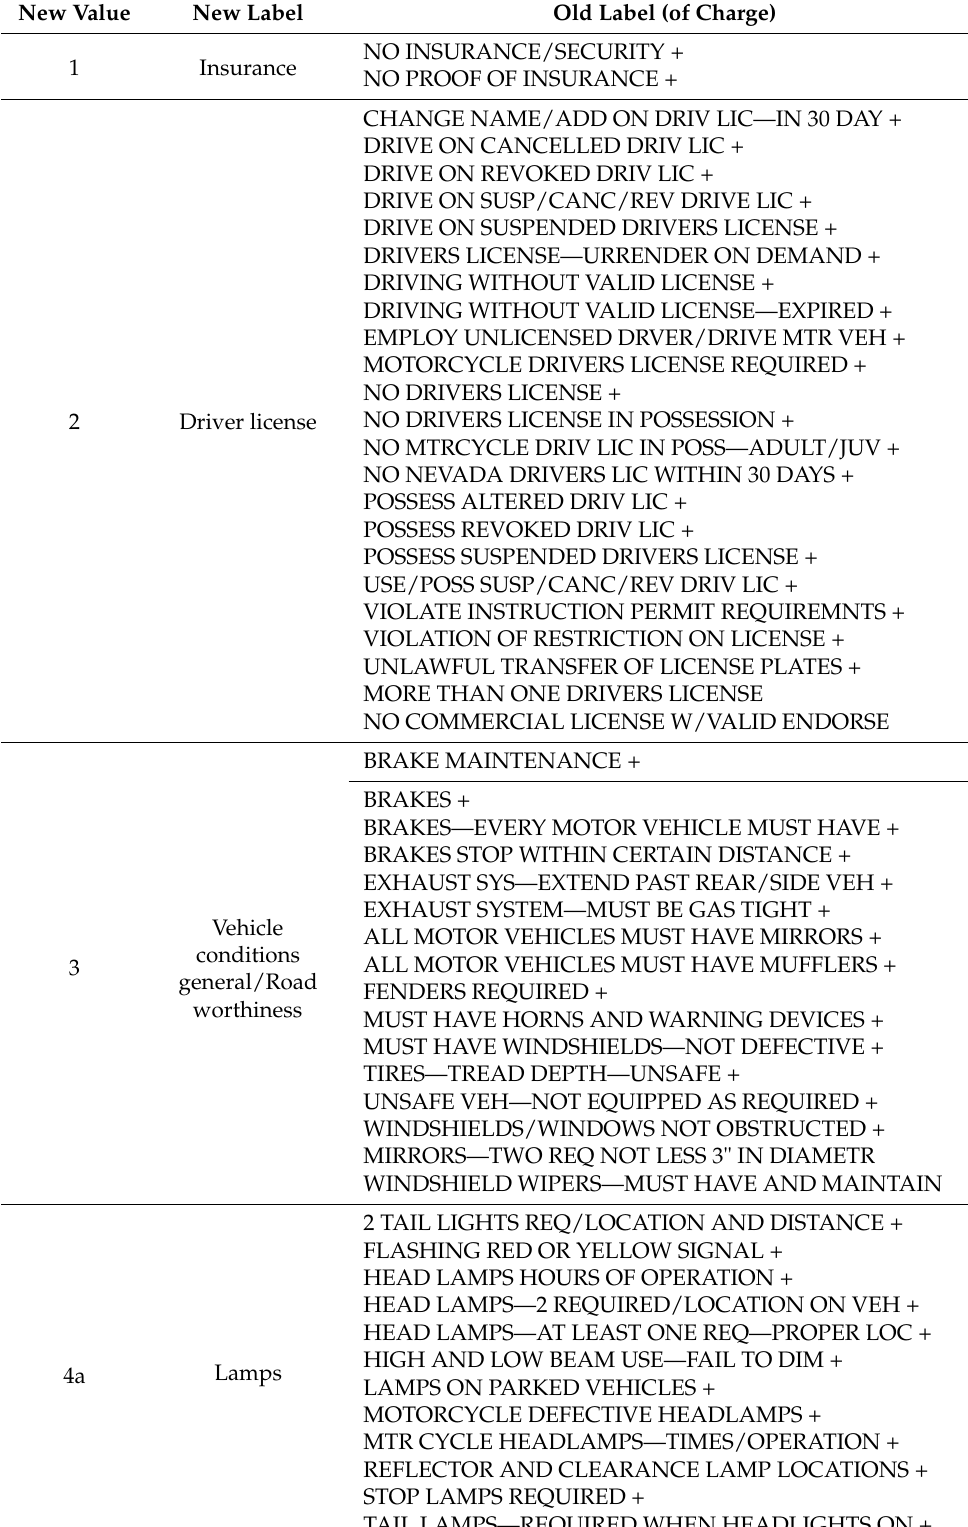
Table A1. Data’s charge categories reduced to 24 new charge category